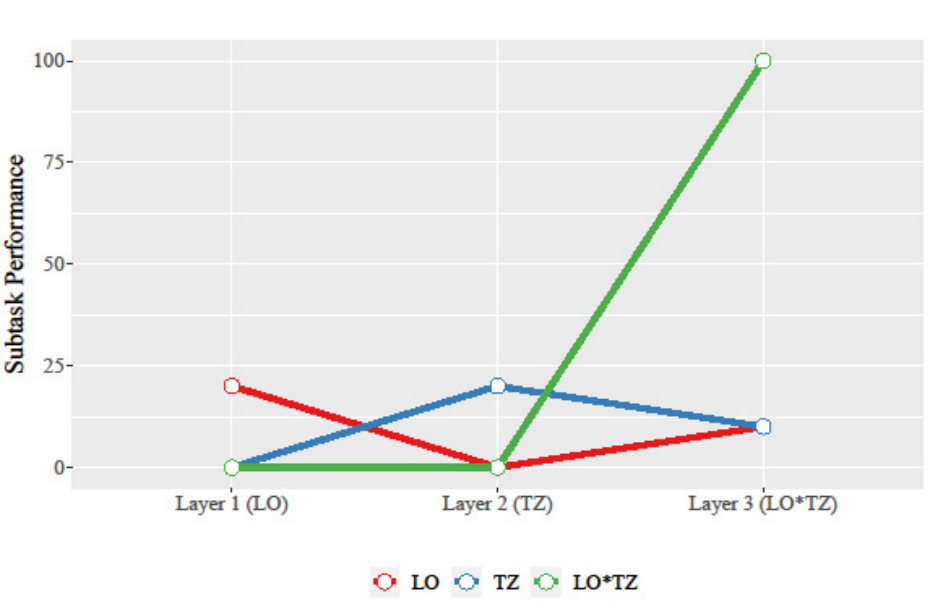
Figure 2 . As the agent transitions to a new subtask, subtask performance also changes. For example, in this 20-bit bitstring, LO proficiency is maximized in Layer 1 (performance of 20), completely lost in Layer 2’s TZ subtask optimization (performance of 0), and partially regained in Layer 3 (score of 10).